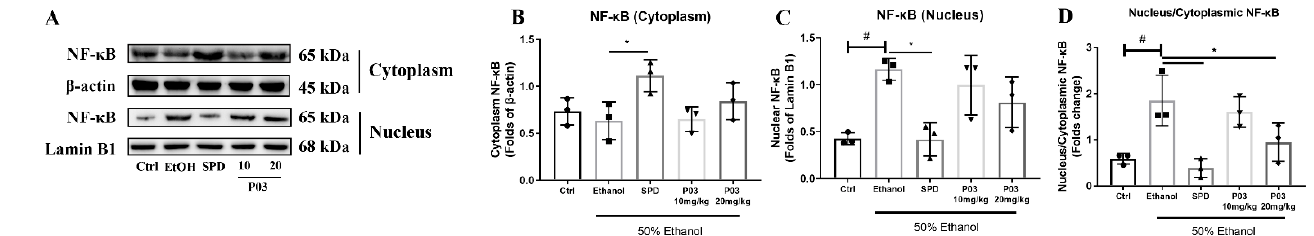
Figure 7. Immunoblots of nuclear and cytoplasmic NF- κ B. ( A ) Western blot analysis of NF- κ B in different groups. ( B – D ) Relative protein levels of NF- κ B in nucleus and cytoplasm in each group. Densitometric quantification of nuclear and cytoplasmic NF- κ B were performed and normalized to β -actin levels (for the cytosolic factions) or Lamin B1 (for the nuclear fractions). The values are represented as mean ± SD and plotted as fold-change. (Compared to Ctrl, # p < 0.05. Compared to ethanol, * p < 0.05).